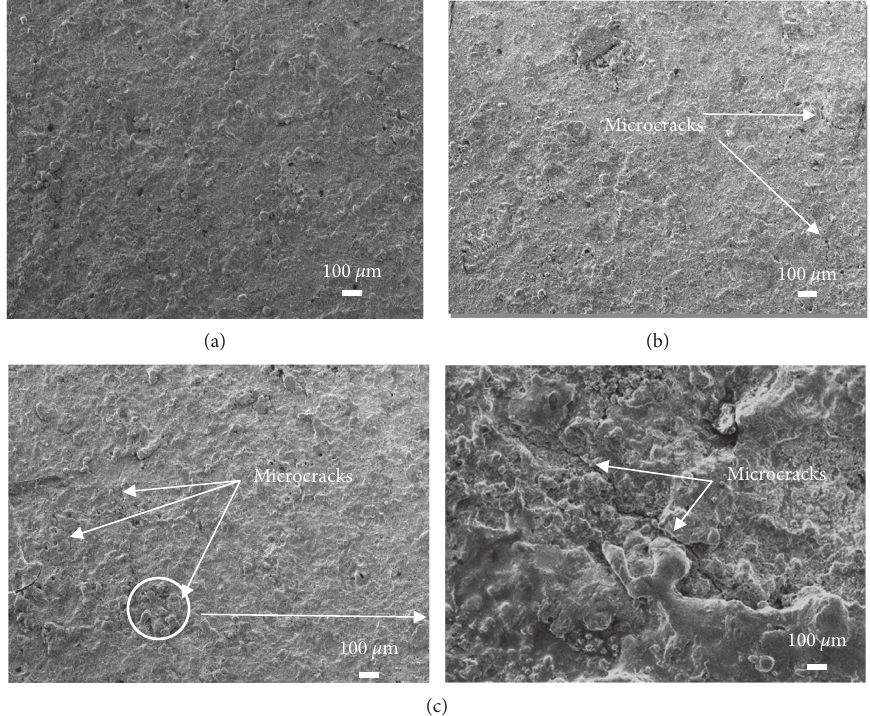
Figure 5: Microstructure of the coating with different volume ratios of h-BN to Cu. (a) 12.5%. (b) 26%. (c)